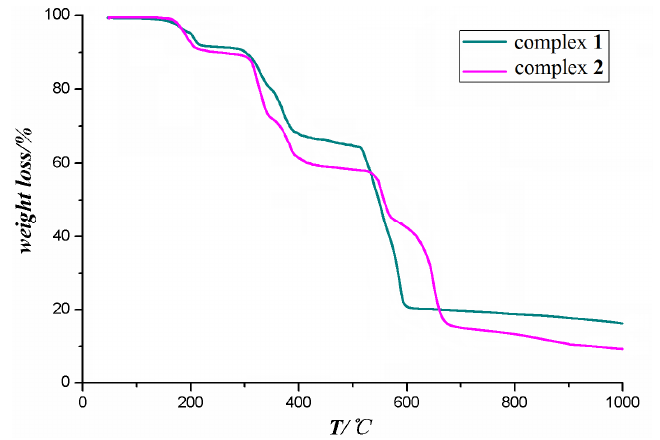
Figure 11. The TG curves of the two complexes.